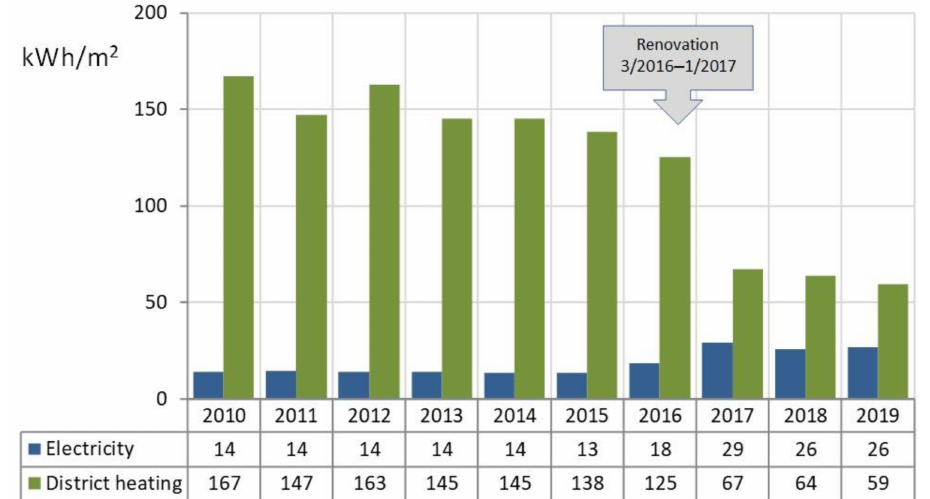
Figure 6. Annual specific district heat and electricity consumption. The renovation was done from